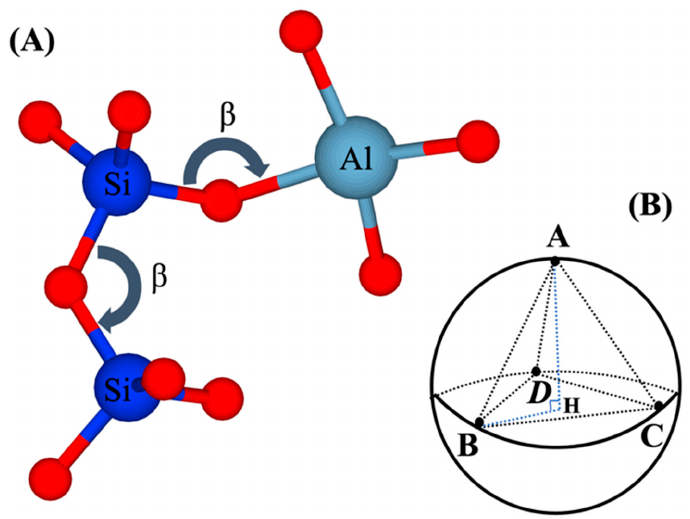
Figure 1. ( A ) Formation of Si-O-Si and Si-O-Al bonds which respect the β angle and tetrahedral geometrical constraints. ( B ) Tetrahedron constraints are expressed with four points ABCD on the unit sphere (coarse-grained particle) during the binding (particle association/aggregation)